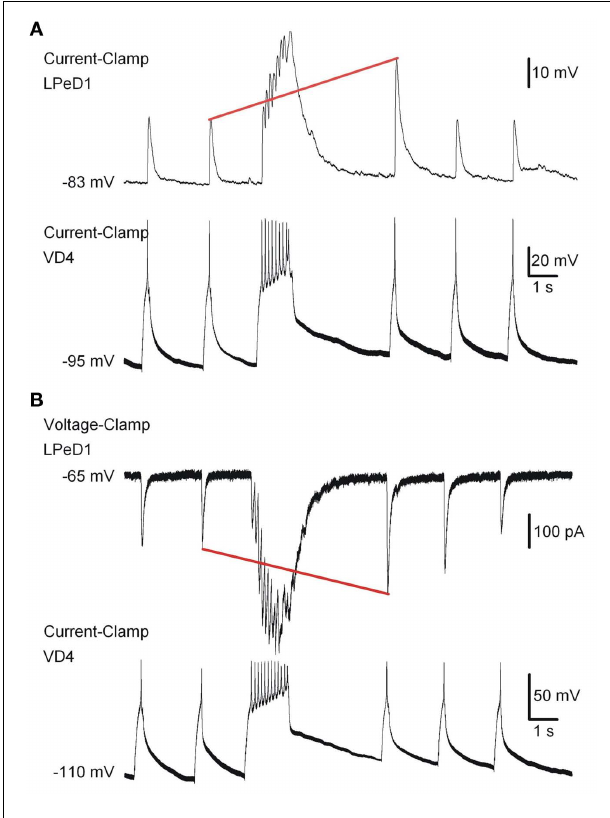
FIGURE 8 | Simultaneous electrophysiological current-clamp (A) and voltage-clamp (B) recordings of LPeD1 (patch-clamp) andVD4 neurons (sharp electrode) forming a synaptic connection on a Si chip. Synaptic responses (EPSP and EPSC) recorded in the LPeD1‘neuron are evoked by stimulating the pre-synapticVD4 neuron. Note that the synaptic response in the LPeD1 neuron is potentiated (red line) after the tetanic stimulation applied to theVD4 neuron. From Martina et al.